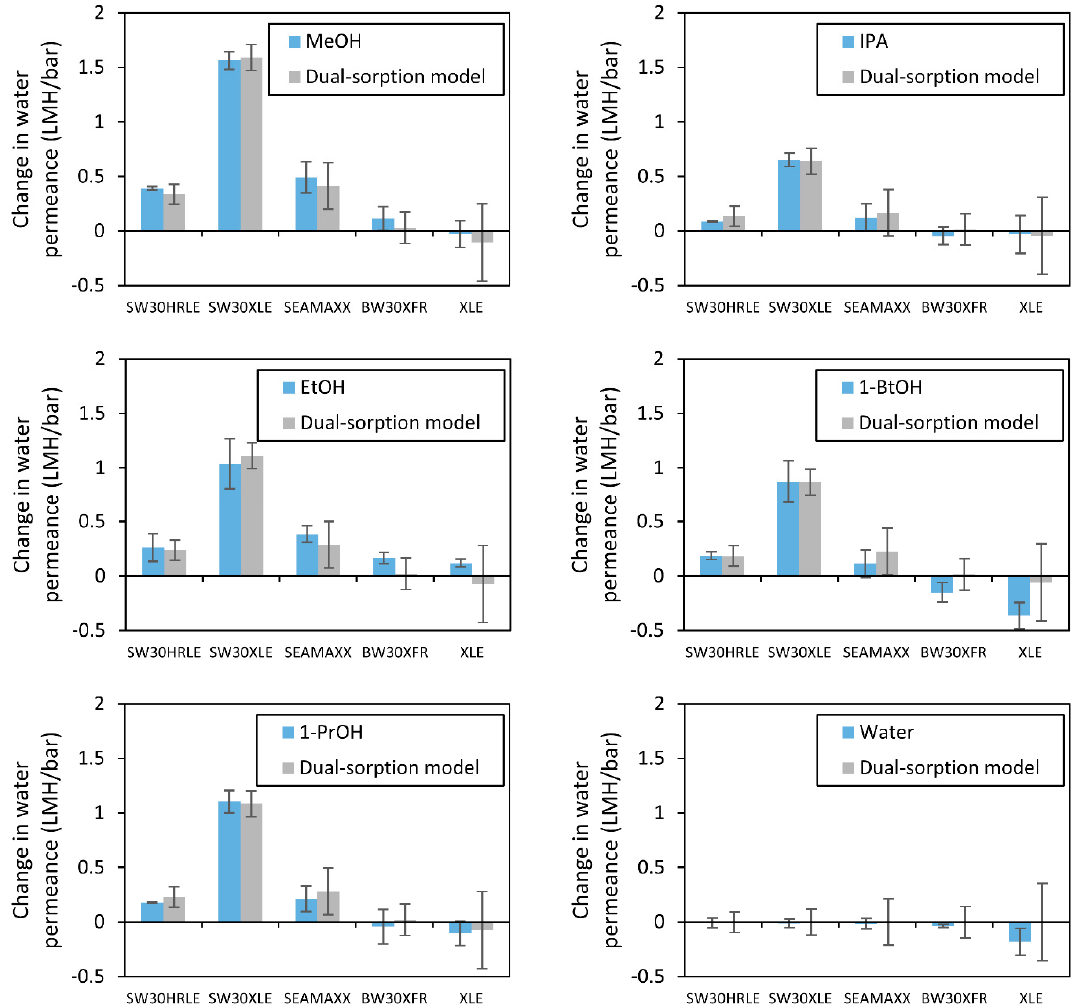
Figure 5. Change in water permeance ( A f –A 0 ) (blue bars ; LMH/bar) after contact with different alcohols for 5 min. Gray bars indicate dual-mode sorption model fits of the data. Error bars represent one standard deviation of at least three measurements ( blue bars ) and error propagation of the initial water permeance (Table 1) in the model ( gray bars ).